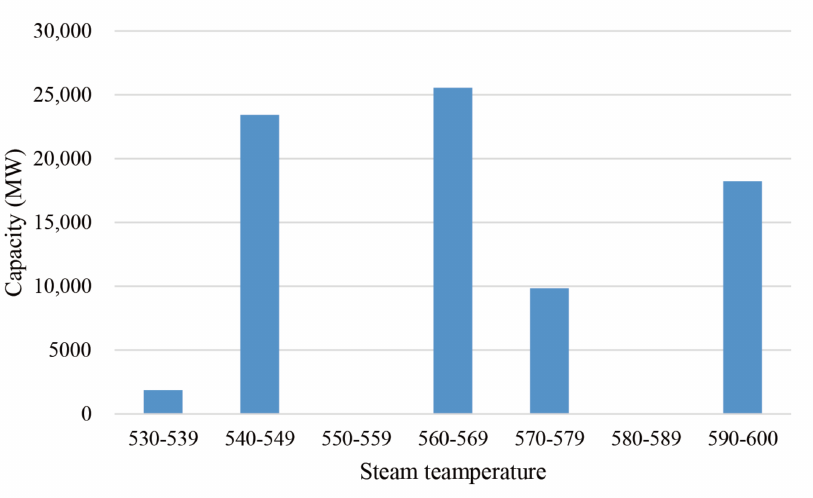
Figure 4. Maximum steam temperature of modern (<15 y) large (>50 MWe) China coal